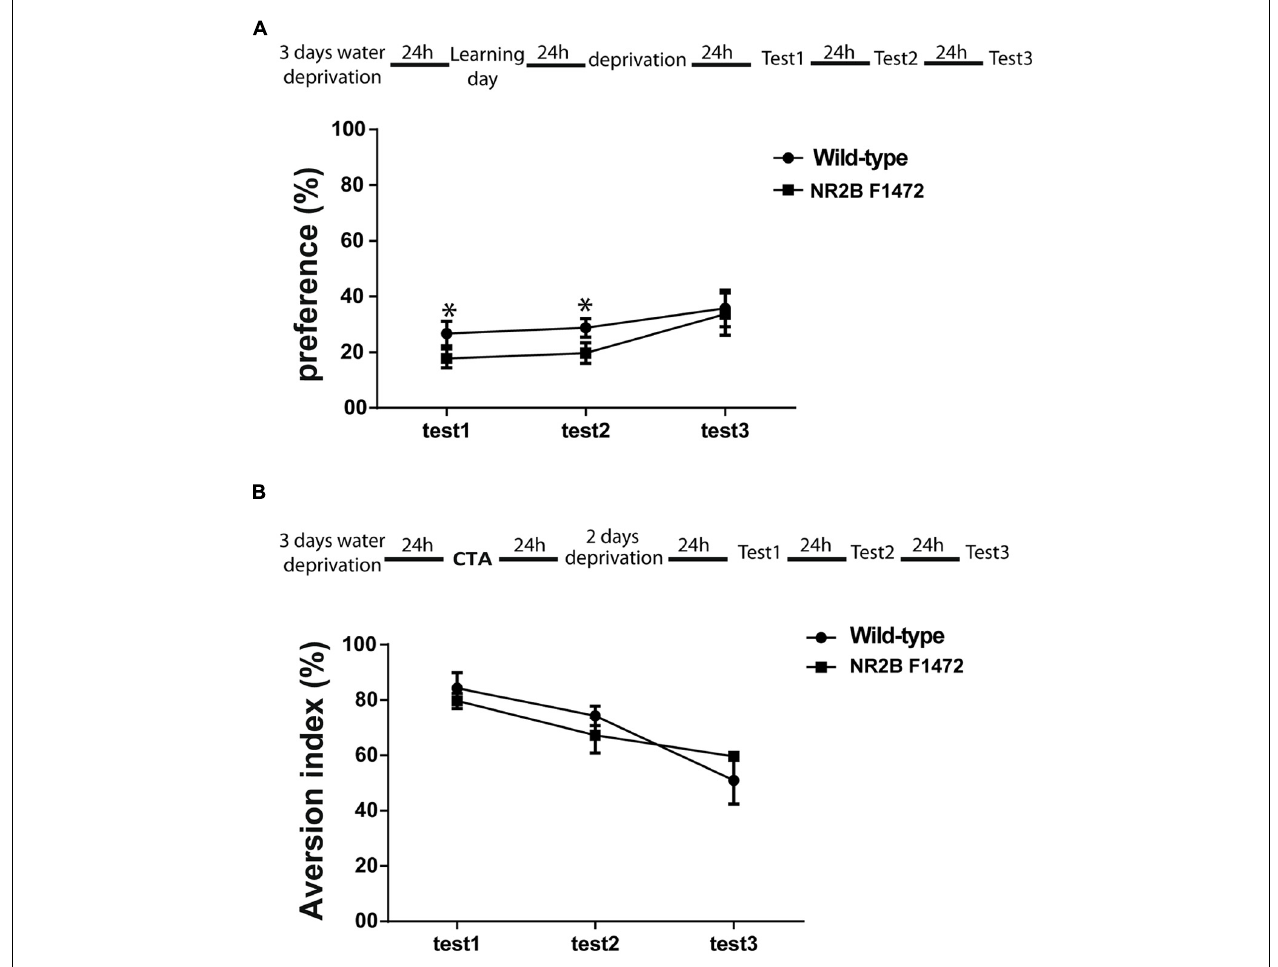
FIGURE 5 | NR2BY1472 phosphorylation is necessary for novel taste learning. (A) NR2B F1472 mice prefer significantly less novel taste on the first and second choice tests (* p < 0.05). However, attenuation of neophobia